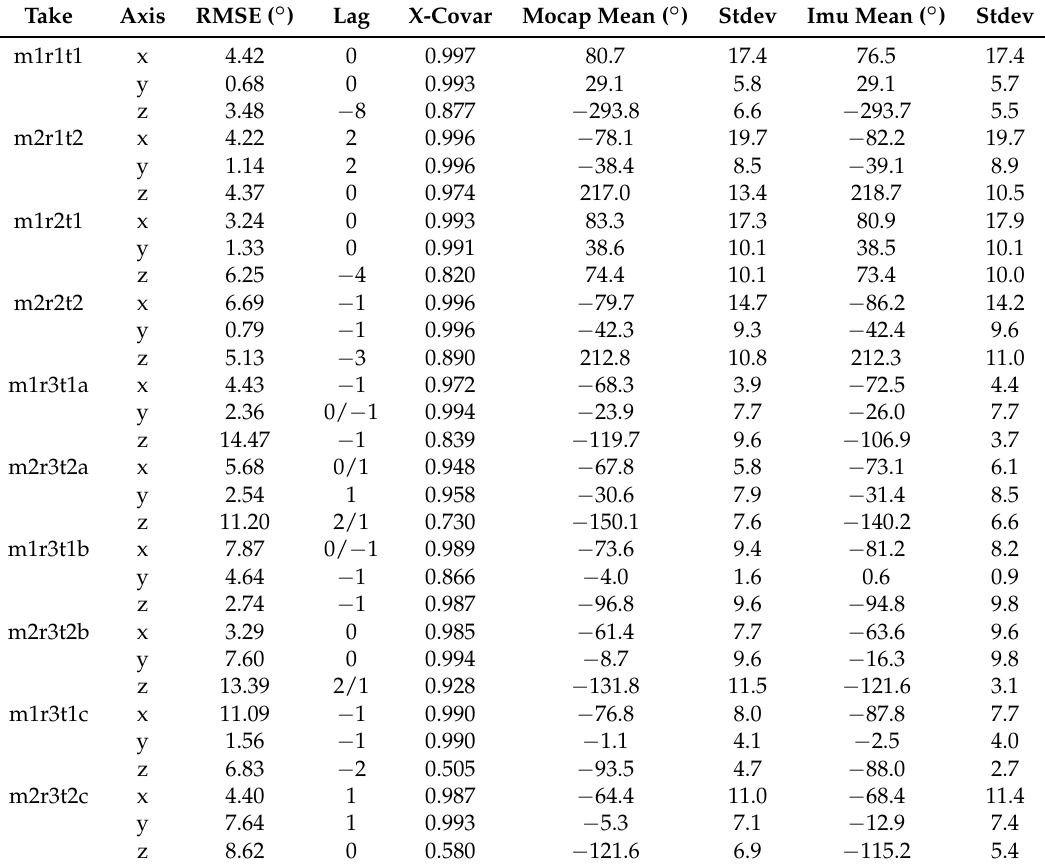
Table 2. RMSE and covariances (per axis) between rotational data generated by each system—selected takes from musicians 1 and